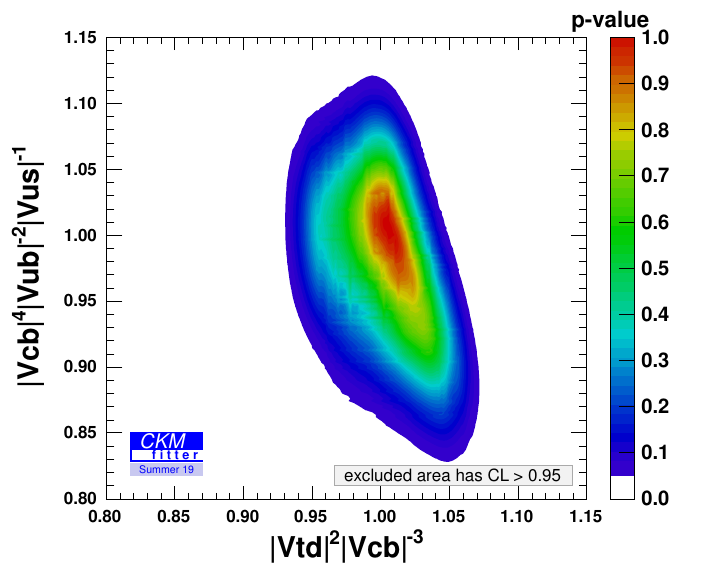
Figure 1 . The correlation between the two relations, R 1 and R 2 , defined in eq. (2.3) [18].